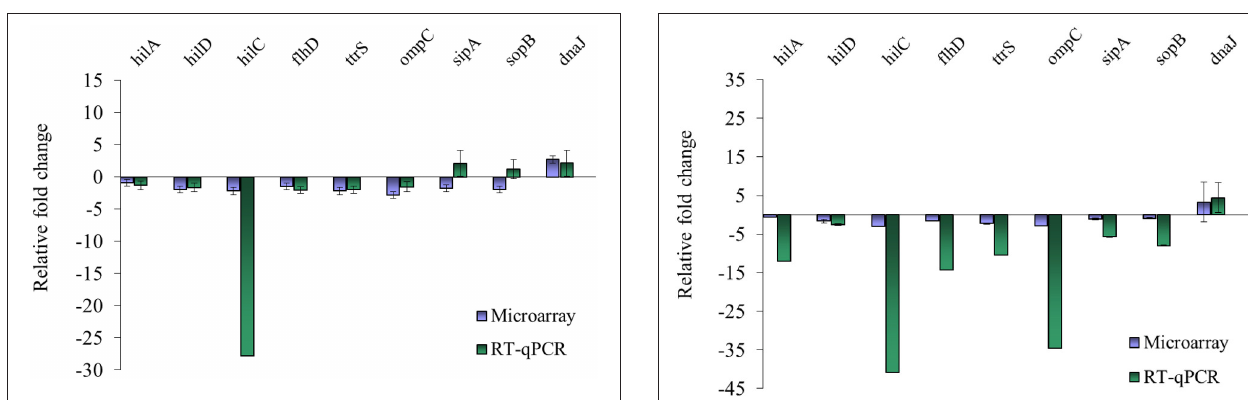
FIGURE 2 | Comparison of microarray and RT-qPCR data on select genes after exposure of S . Enteritidis PT8 to SICs of EG. Data are from three